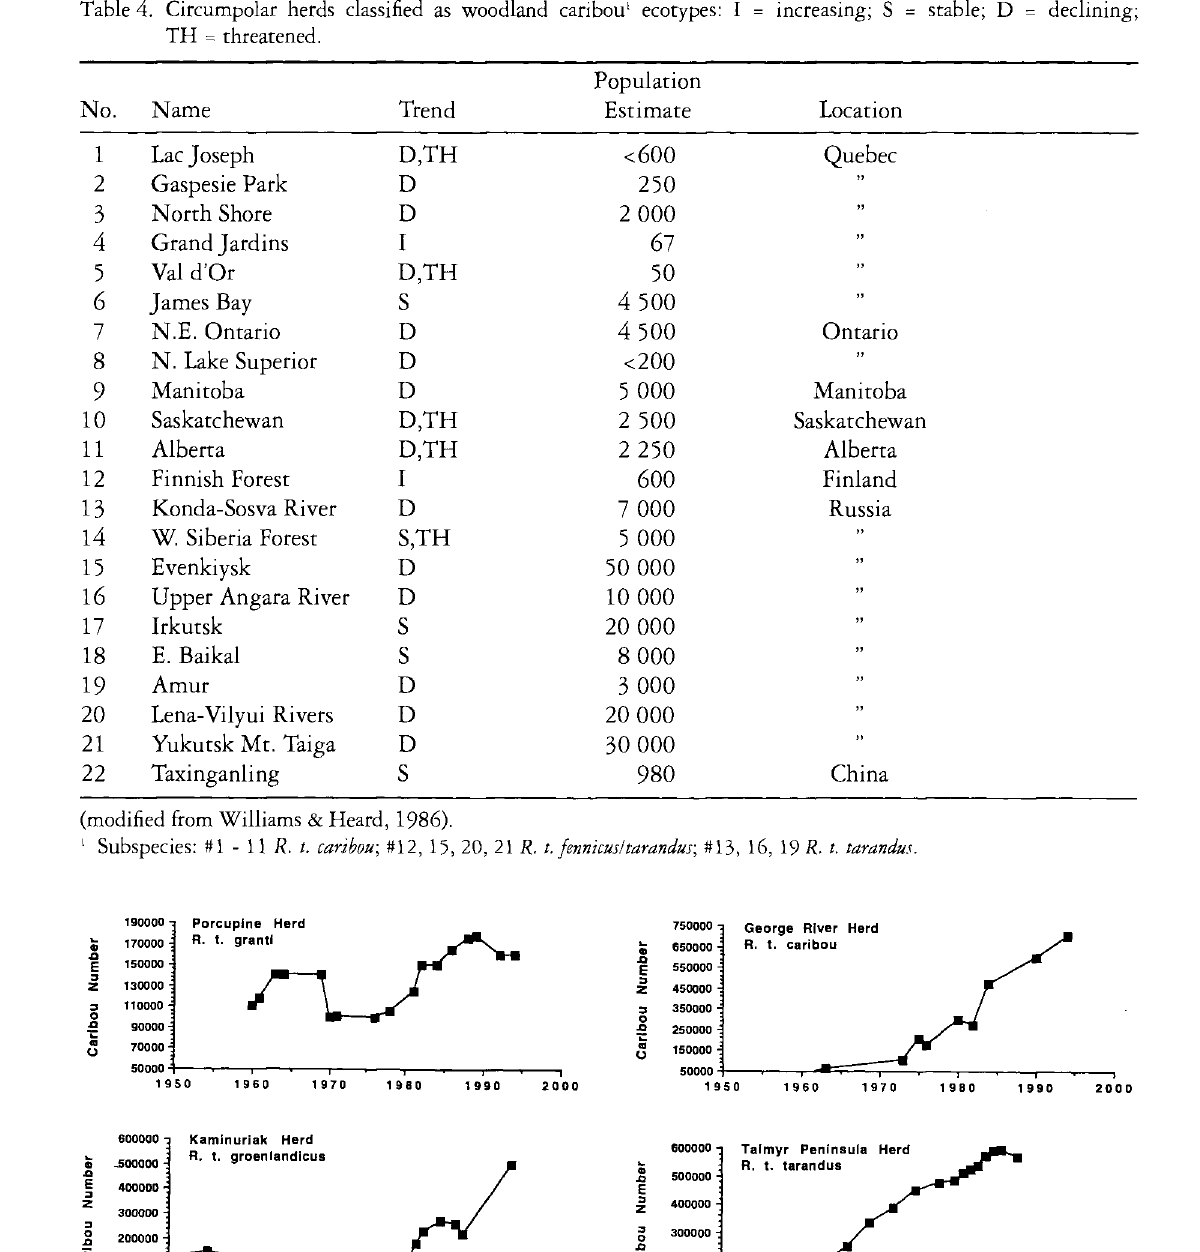
Figs. 5-8. Comparison of population growth in 4 barren-ground ecotype herds during the past 5 decades.